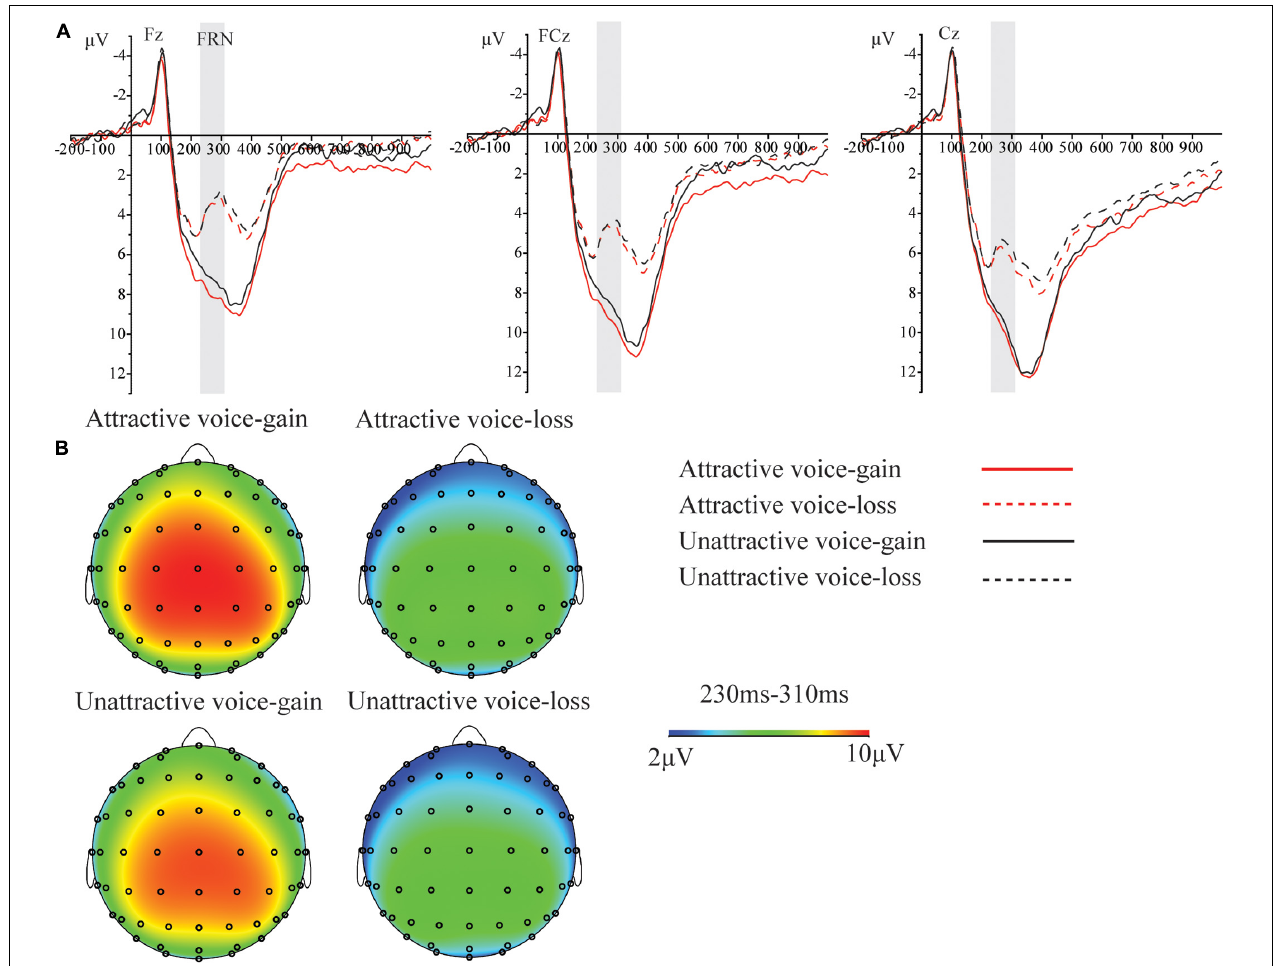
FIGURE 5 | (A) Grand average ERPs induced by the feedback of gain and loss at three representative electrodes in the attractive and unattractive voice conditions. (B) Topography of scalp distribution and waves generated by gain and loss in the attractive and unattractive voice